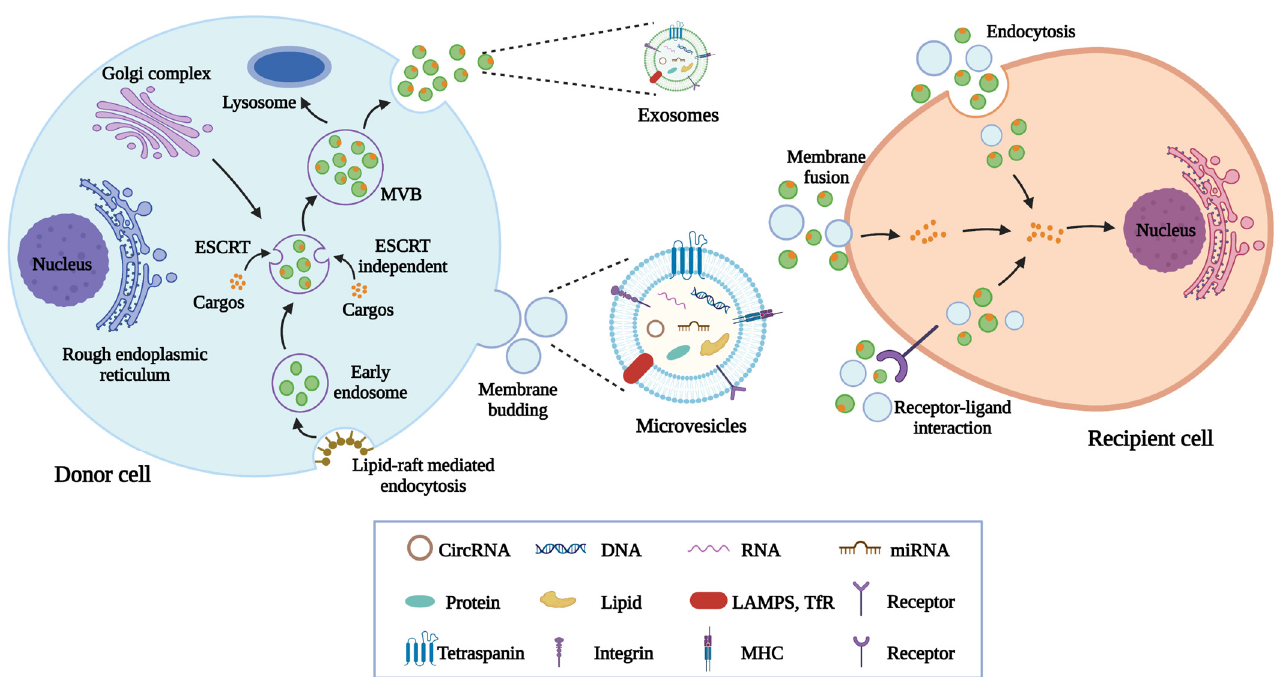
Figure 1. The biogenesis, release, and internalization of EVs. The generation of exosomes involves several processes including endocytosis, endosomes and MVBs formation, and the fusion of MVBs with plasma membranes. Microvesicles are formed after the outward budding of plasma membranes. EVs transport cargos including proteins, nucleic acids, and lipids to recipient cells through endocytosis, membrane fusion, and receptor–ligand interaction. Table 1. Evaluation of isolation methods of